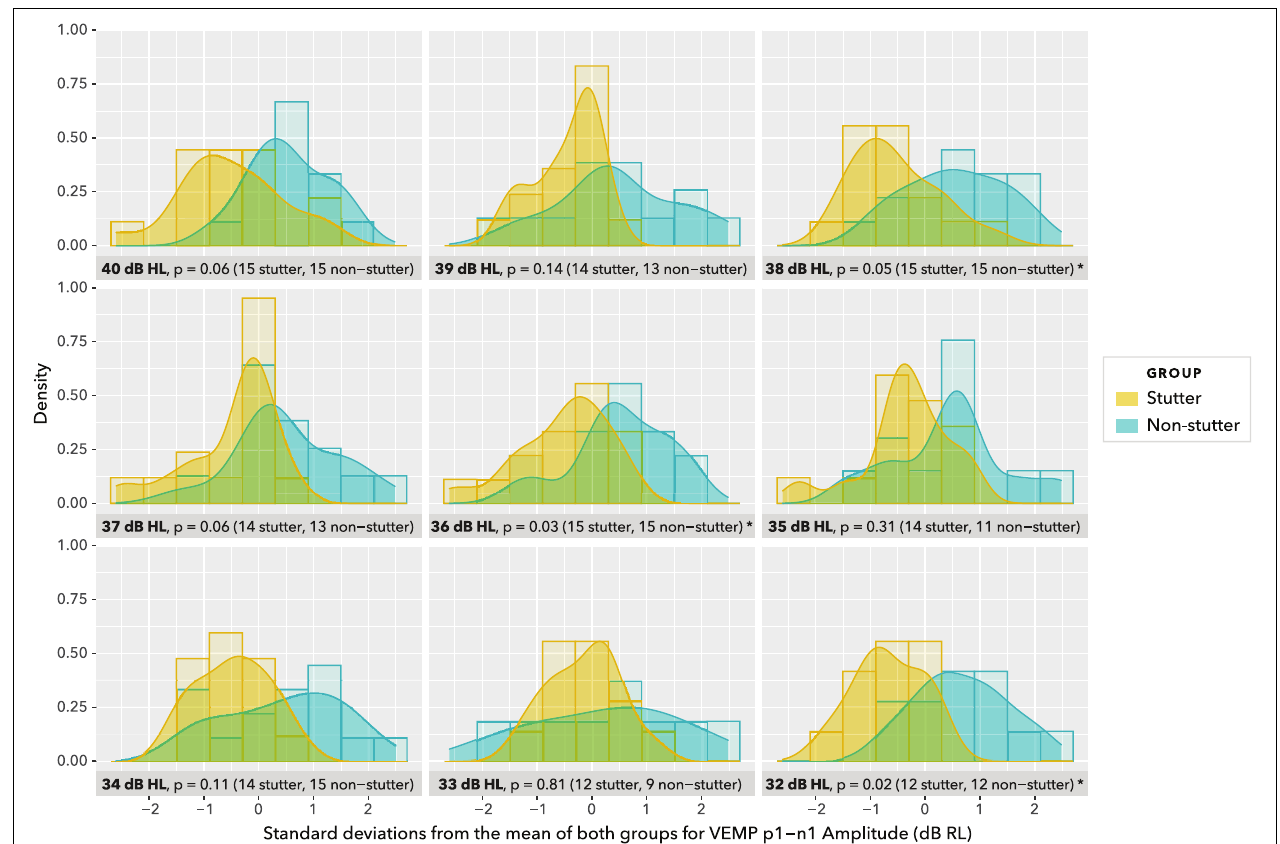
FIGURE 9 | Density plots at stimulus levels between 40 dB HL and 32 dB HL. Histograms are shown in the background. Uncorrected t -tests show group differences at p ≤ 0.05 for 38, 36, and 32 dB HL, and p = 0.06 for 40 and 37 dB HL. Group sizes are unbalanced at 35 and 33 dB HL. This view of data with uncorrected t -tests is for illustration purposes only. Repeated measures at the same stimulus level are excluded, as are data at stimulus levels below 32 dB HL, and no account is made of trends in participants across stimulus levels. The actual statistical analysis is by linear mixed-effects regression modelling, and is described in the sections “Statistical Model” and “VEMP p1-n1 Amplitude.”